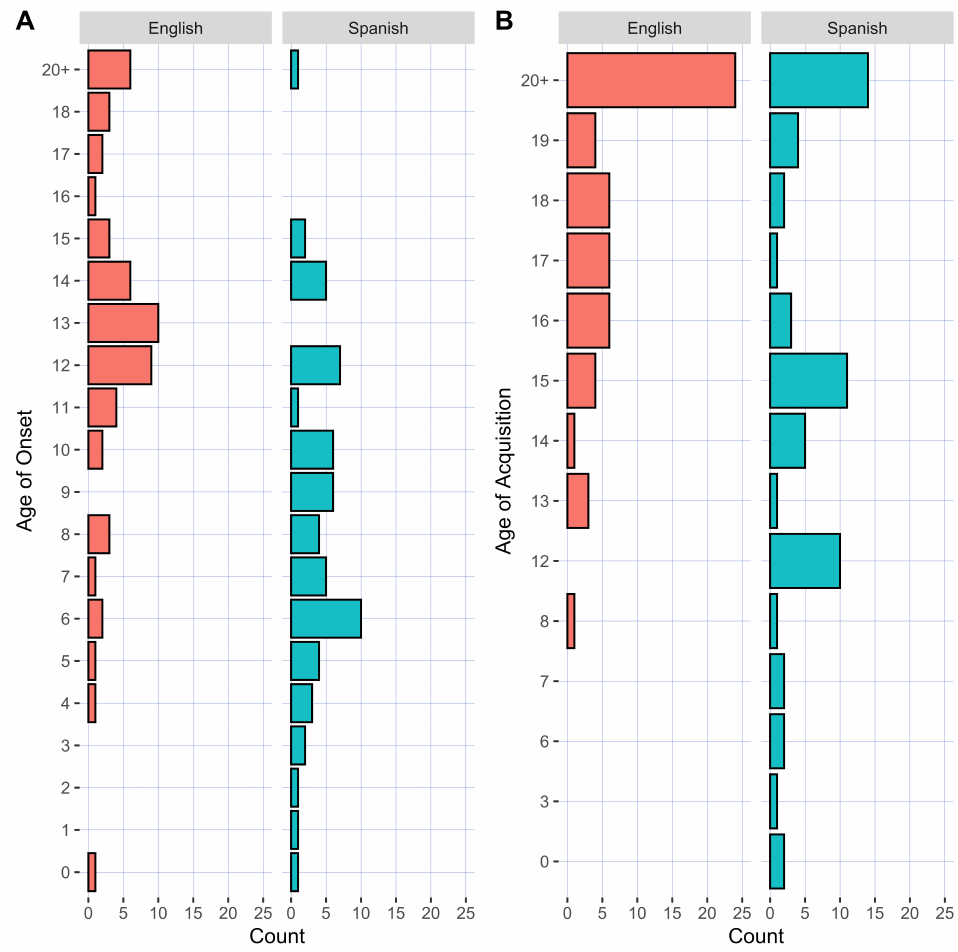
Figure 1. ( A ) Self-reported age of onset of L2 learning, where the panel name represents that participants’ L2 ( B ) Self-reported age of acquisition, in which the participant reported first feeling comfortable in their